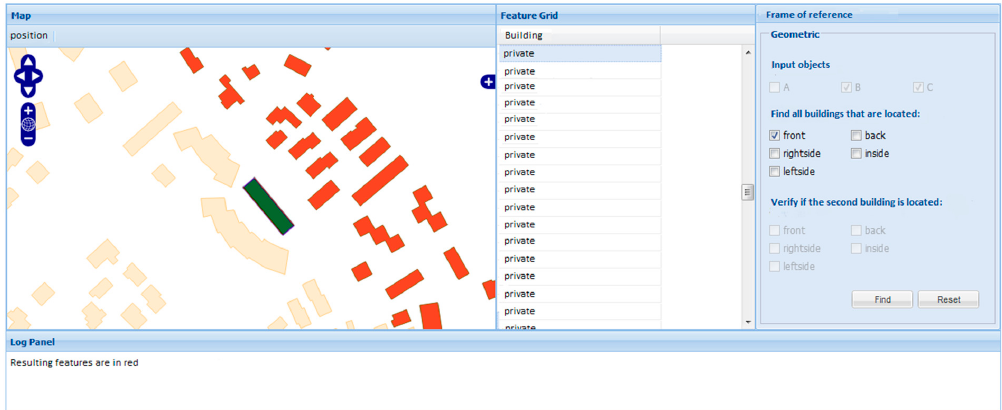
Figure 16. Buildings in front of the selected building.